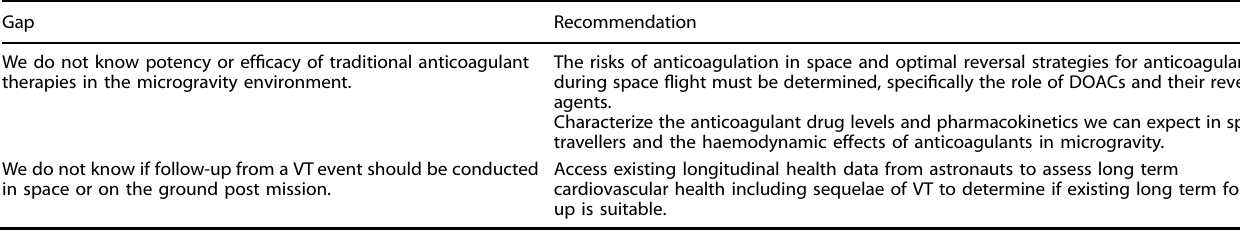
Table 5. Management — Gap Analysis and Recommendations. Gap